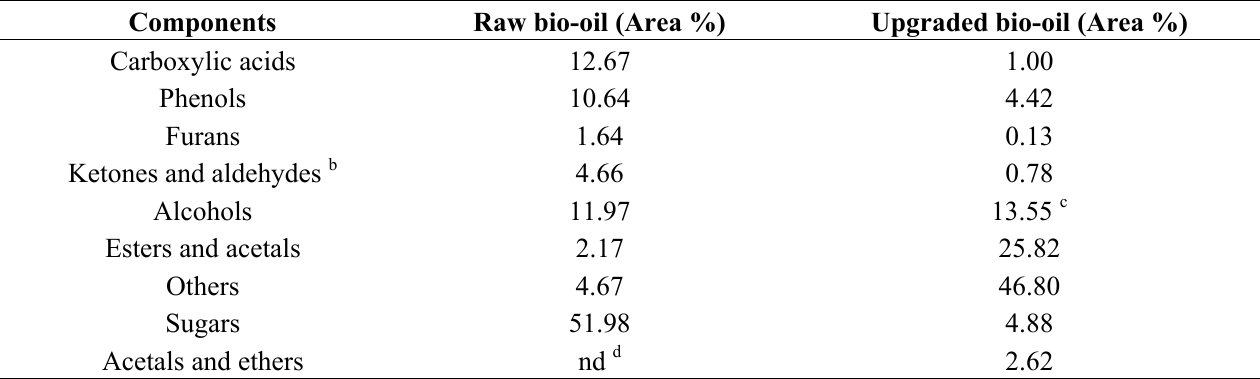
Table 3. A general breakdown of the components of raw bio-oil a and bio-oil upgraded with 1-octene/1-butanol at 120 °C for 3 h b